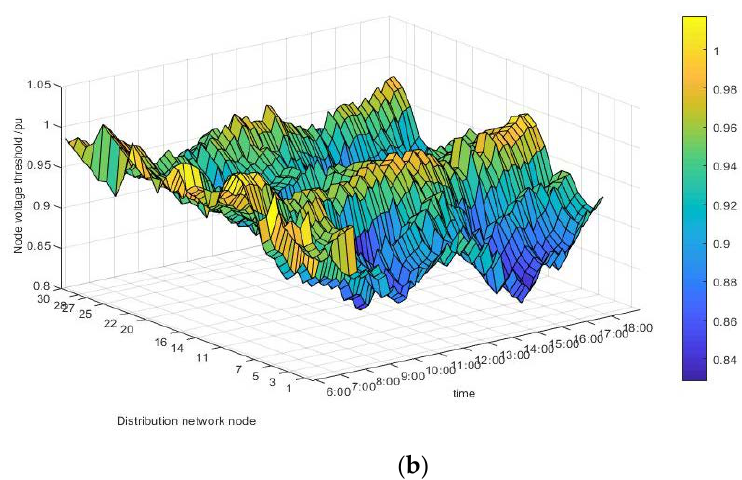
Figure 11. Distribution voltage distribution of 30-node distribution network in different scenarios. ( a ) 30-node distribution network voltage under the optimal charging path navigation; ( b ) voltage of 30-node distribution network without optimized charging strategy.